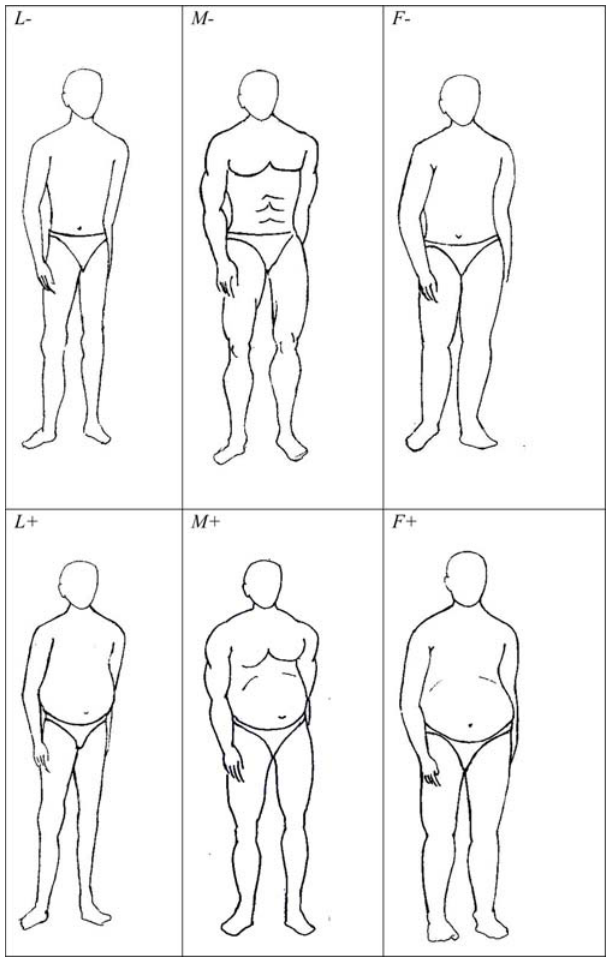
Figure 1. The six body forms used in the study: Three types of body forms were as shown in columns. 1. Lean ( L - narrow shoulders, thin torso and extremities, knee and elbow joints thicker than thy and arm diameter). 2. Muscular ( M – Broad shoulders, curved extremities, chest and abdominal muscles shown, thy and arm diameters greater than knee and elbow joints). 3. Slightly fat and feminine ( F – rounded shoulders, cylindrical extremities). Each of the three body forms was represented with (designated by + ) and without ( 2 ) abdominal obesity as shown in rows. The sequence of these figures was randomized during the test and the figures were labeled serially by alphabets.